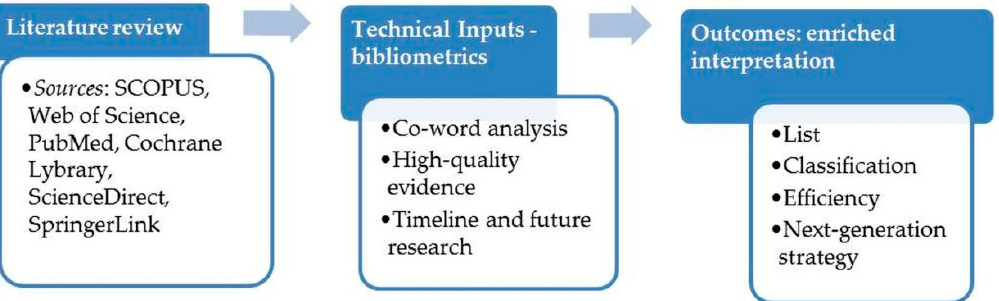
Figure 1. Overview of the Synthetic Antioxidants Progression